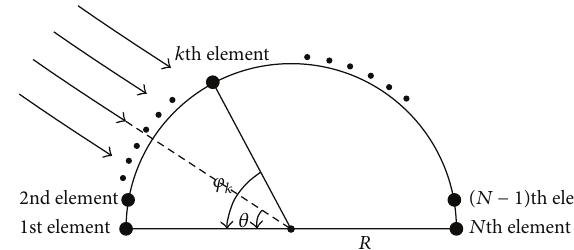
Figure 1: Diagram of the semicircular